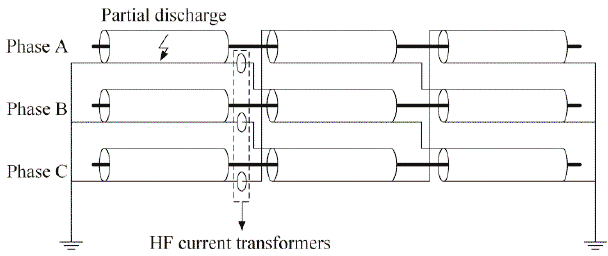
Figure 1. High-frequency current method applied to a three-phase cross-bonded cable unit.